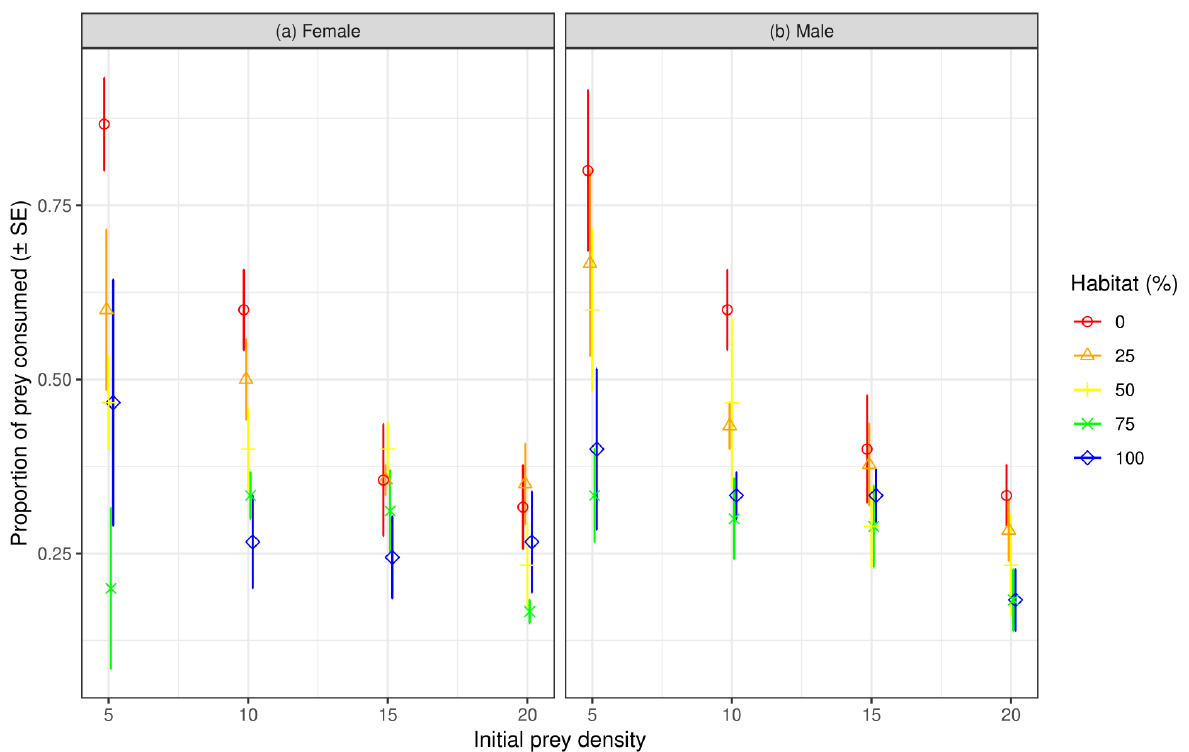
Figure 1. Proportional prey consumption across Mesopodopsis wooldridgei sex (male: ( a ); female: ( b )) and habitat complexity treatments. Means are ±1 standard error (SE). Densities correspond to individuals per arena (2 L volume). Table 1. Mesopodopsis wooldridgei functional response first-order terms, attack rates, and handling times across predator sex and habitat complexity treatments, along with associated p -values. Signif- icant p -values are emboldened.